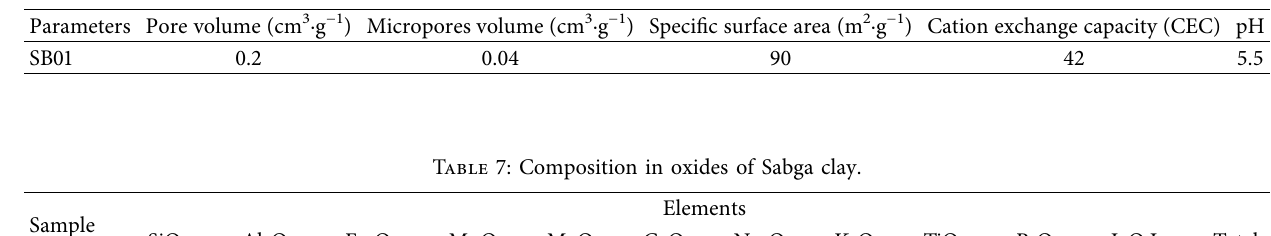
Table 6: Physical characteristics of Sabga smectic clay.